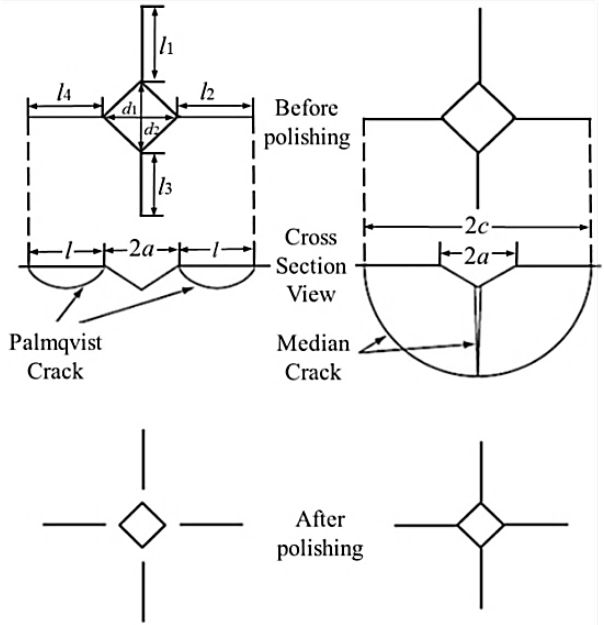
Figure 4. Palmqvist and median crack system developed from the Vickers indents, before and after polishing [29].